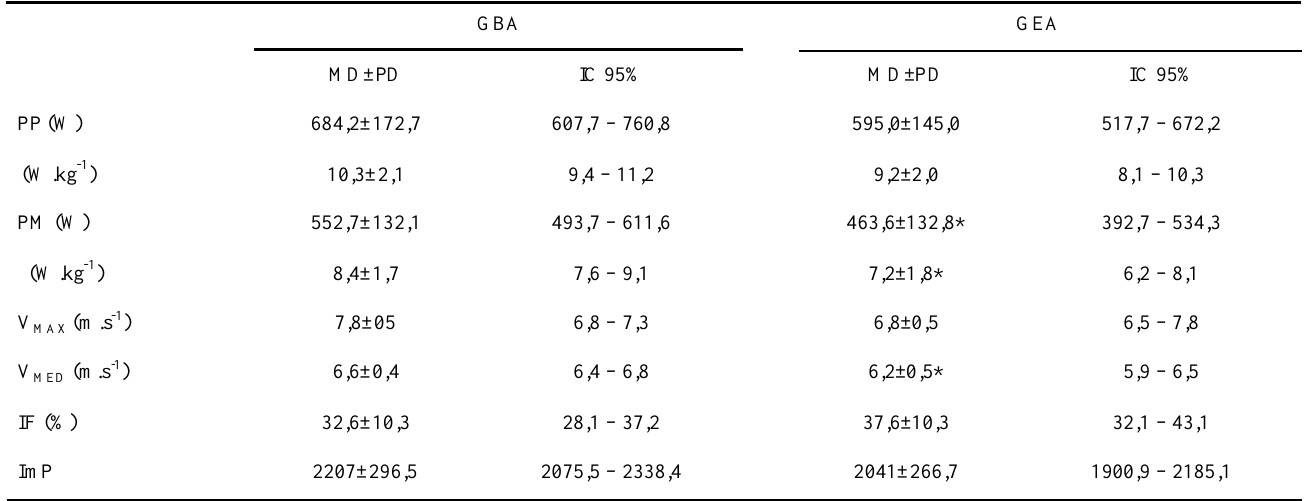
Tabela 2 . Valores médios (MD) ± desvio padrão (DP) e intervalo de confiança 95% (IC 95%) para variáveis provenientes do RAST. Potência pico (PP), média (PM), velocidade máxima (V ) e média (V ), índice de fadiga (IF) e o impulso (ImP), observados nos grupos, baixa aptidão MAX MED aeróbia (GBA) e alta aptidão aeróbia (GEA).